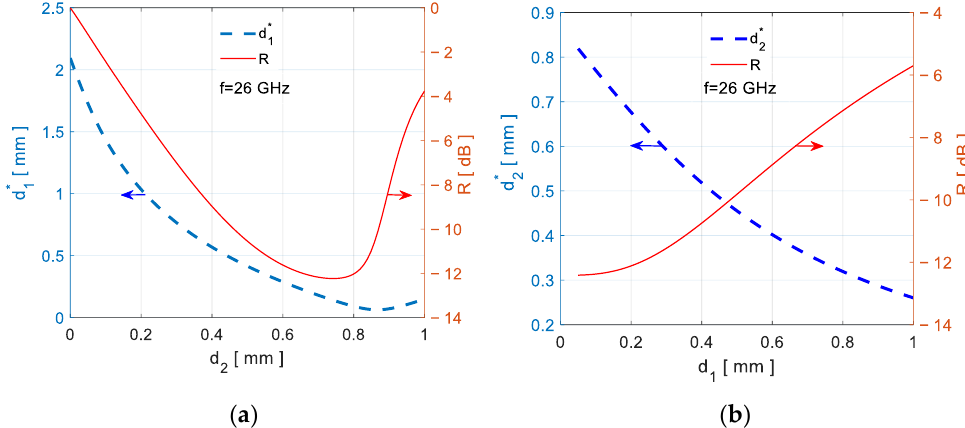
Figure 5. Optimal thicknesses 𝑑 1∗ ( 𝑑 2 ) ( a ) and 𝑑 2∗ (𝑑 1 ) ( b ) at target frequency of 26 GHz.